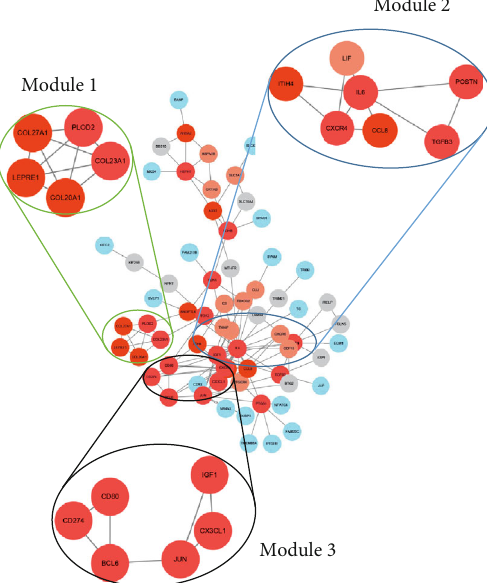
Figure 6: Interaction between DEGs in weightless osteoporosis. PPI network analysis of DEGs as well as the top 3 modules from PPI network. Every edge represented the interaction between two